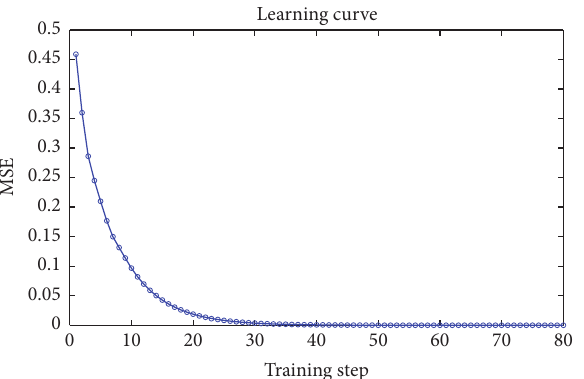
Figure 5: The learning curve of the RBF neural